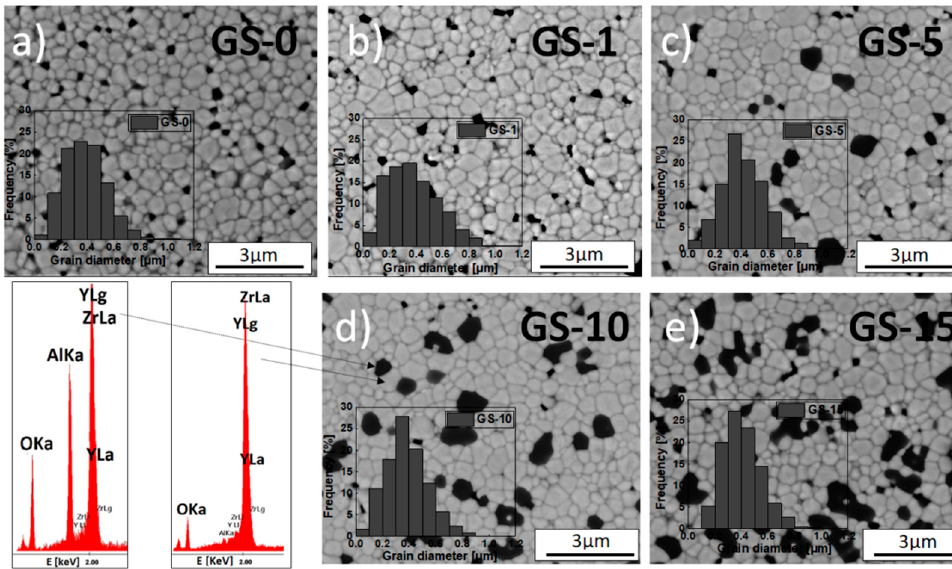
Figure 4. SEM micrographs of fractured sections of GS samples: ( a ) GS-0, ( b ) GS-1, ( c ) GS-5, ( d ) GS-10 and ( e ) GS-15 and the results of EDS point analyses for the area corresponding to the 3Y-TZP matrix and alumina inclusions in the GS-10 sample. Alumina addition performed via the gelatin method. All sinters obtained after 2 h of sintering in air at 1773 K. Inset: grain size distribution.